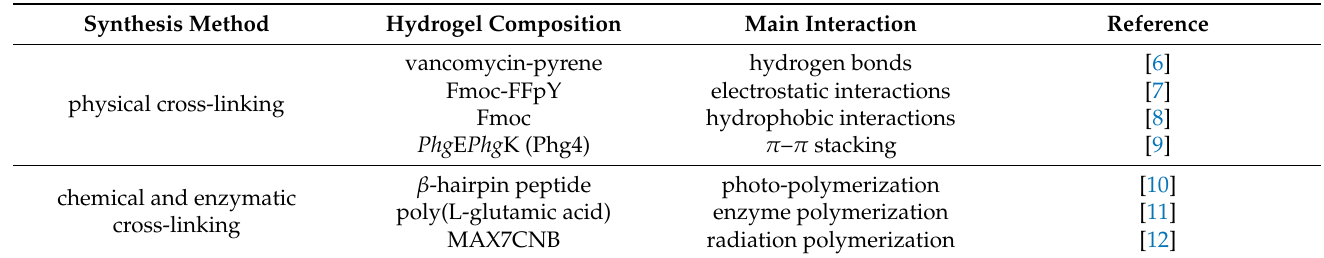
Table 1. Some representative examples of physical and chemical methods for the synthesis of peptide-based hydrogels.